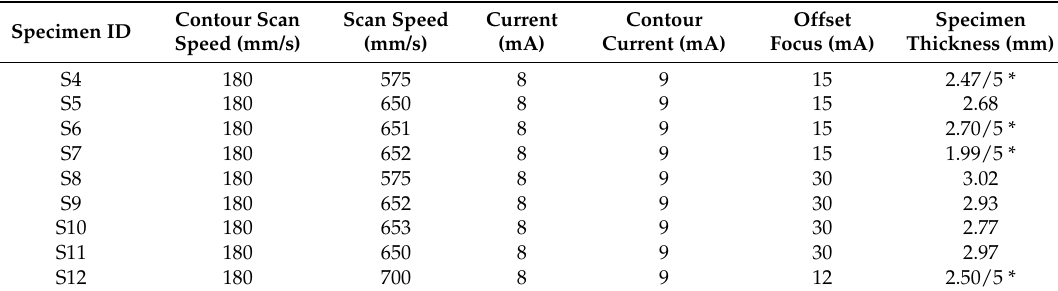
Table 1. Specimen process parameters.